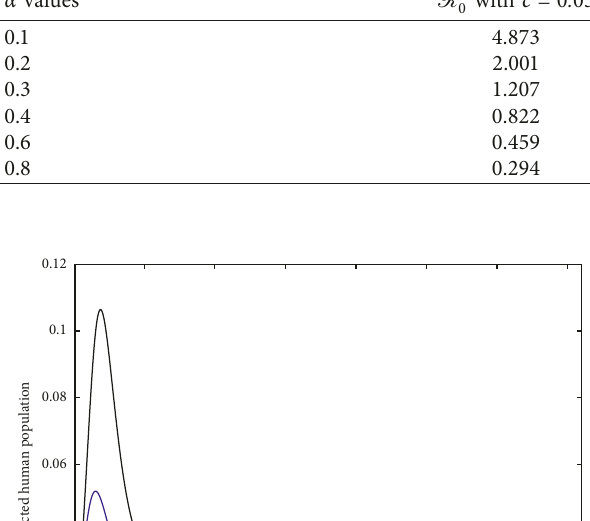
Figure 4: A plot showing the effect of α on the vector